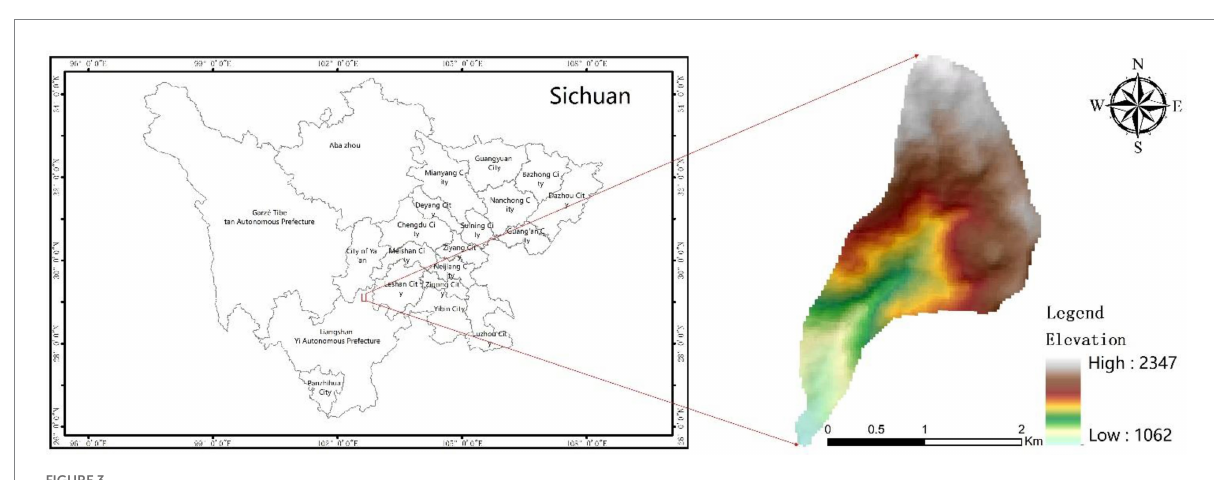
FIGURE 3 Location of the study